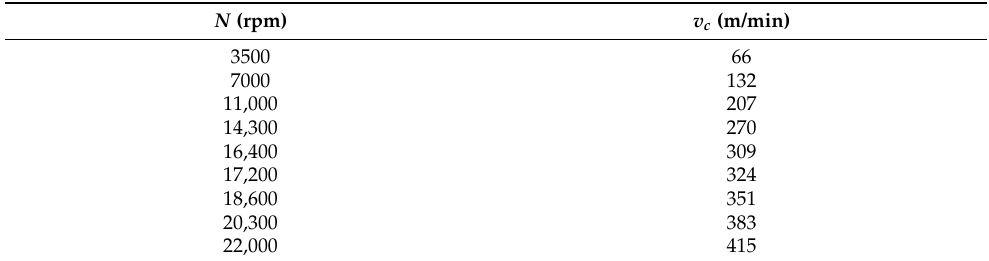
Table 4. Range of N (in rpm) and v c (in m/min) considered for the determination of v c , min .